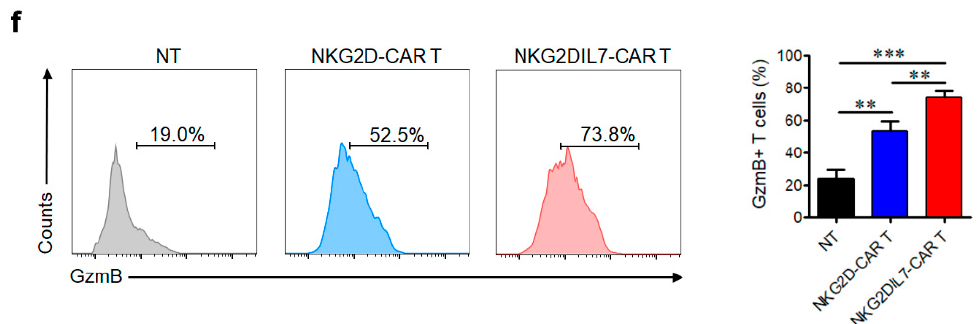
Figure 1. NKG2DIL7-chimeric antigen receptor (CAR T cells display enhanced antitumor activity in vitro. ( a ) Domain architecture of engineered NKG2D-CAR and NKG2DIL7-CAR constructs. ( b ) Cytotoxic activity of NKG2D-CAR or non-transduced T cells against prostate cancer cell lines was determined by Annexin-V staining. B16-F10 melanoma cells served as negative target cell control. The e ff ector cells were co-cultured for 4 h with targeT cells at E:T ratio of 1:3, 1:1 and 3:1, respectively. ( c , d ) Cytotoxic assays were determined by Annexin-V staining at 16 h of co-culture of NKG2D-CAR or NKG2DIL7-CAR T with PC-3 at E:T ratios of 3:1,1:1 and 1:3. E ( c ), PC-3 tumor cell viability assay was performed after 72 h of co-culture with non-transducted T (NT), NKG2D-CAR or NKG2DIL7-CAR T cells at E:T ratio of 3:1 ( d ). ( e , f ) Flow cytometric analysis of CD69 and granzyme B in T cells after the stimulation of tumor cells. * p < 0.05, ** p < 0.01, *** p < 0.001, **** p < 0.0001. Data are representative of greater than three independent